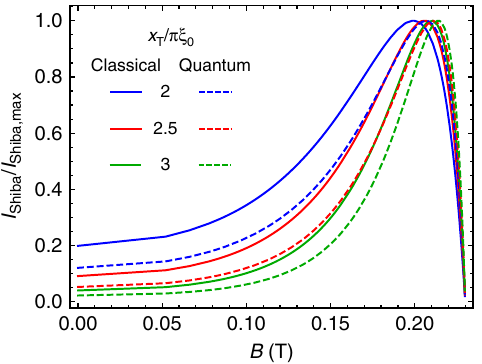
Fig. 7 Comparison of classical theory and NRG. Comparison between the classical expression, Eq. (2) and result involving the NRG calculation,